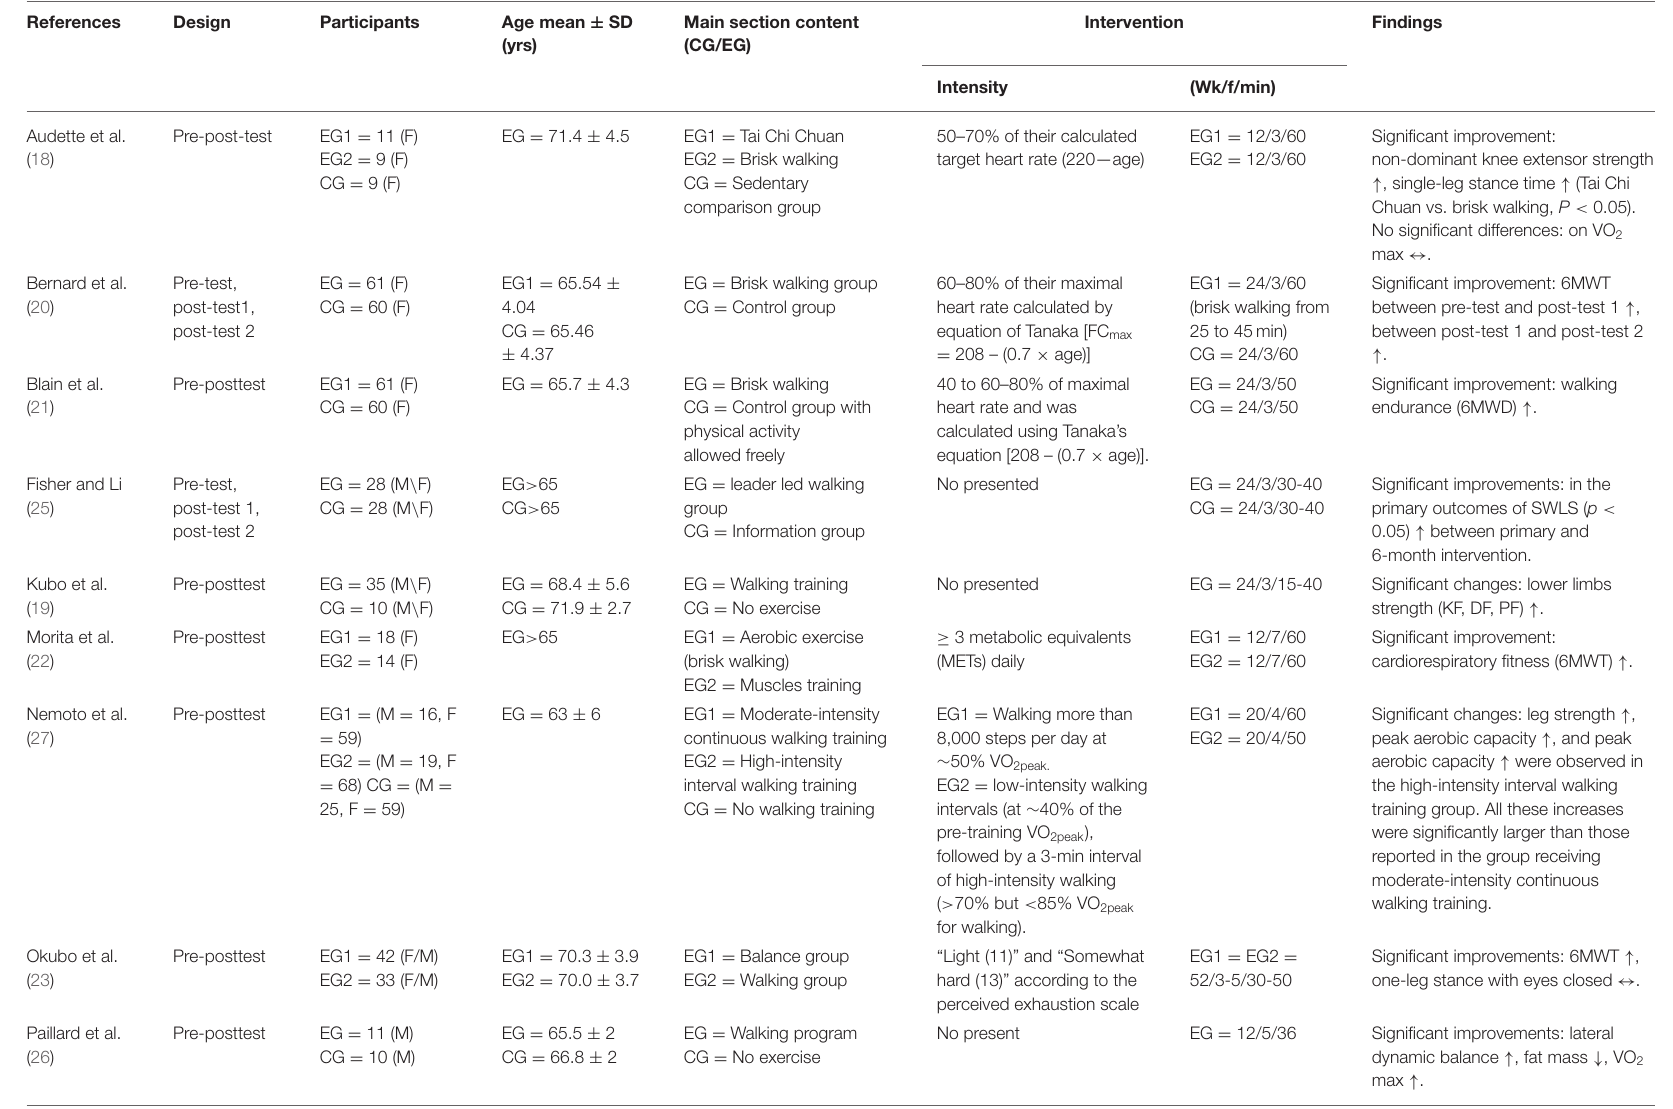
TABLE 3 | Characteristics of the studies examined in the present